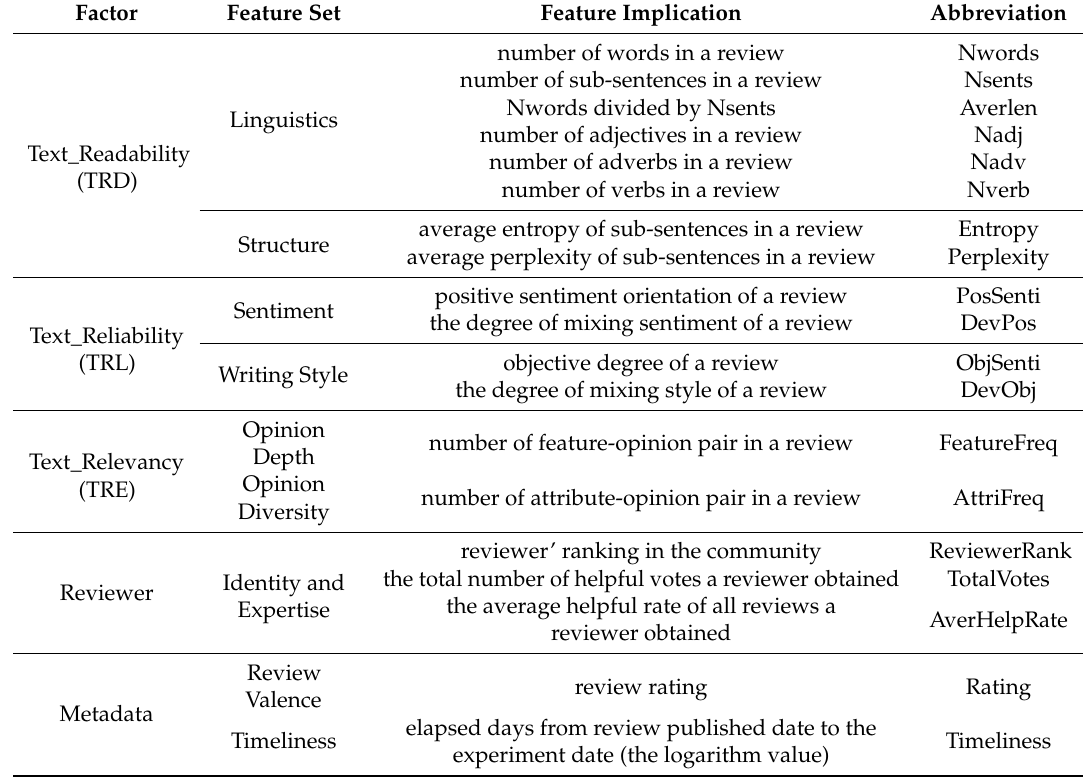
Table 1. Extracted features and